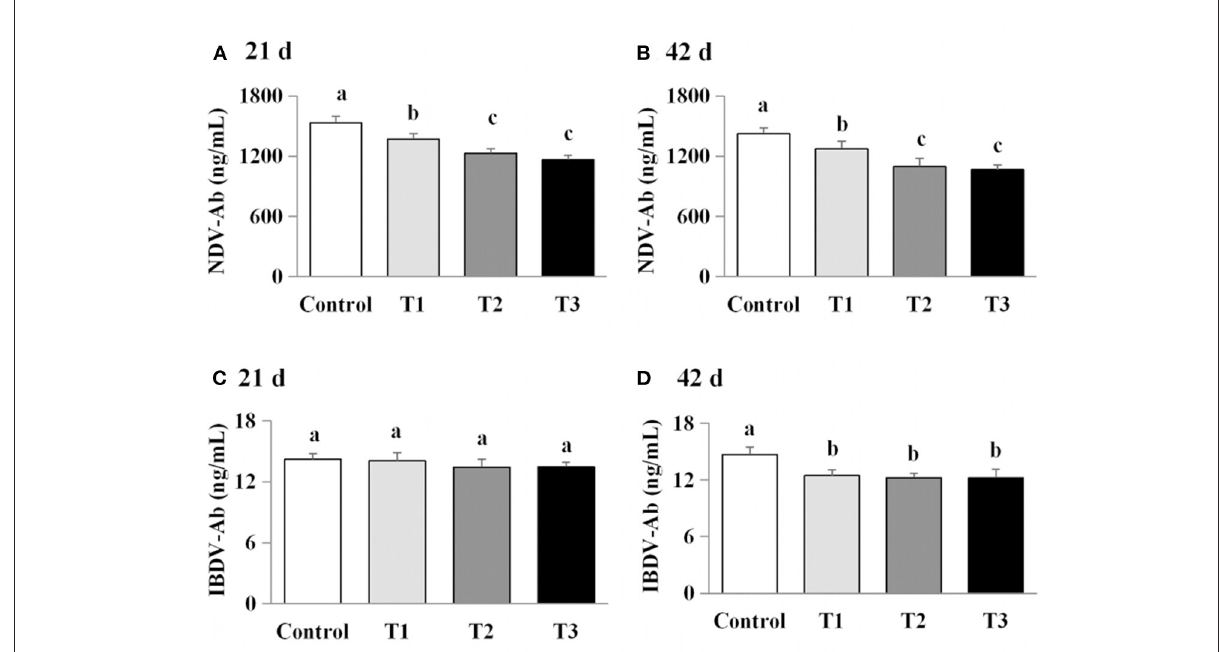
FIGURE4 Effects of AFB 1 on the antibody content in serum of chicks on day 21 and day 42. (A) IBDV-Ab content on day 21. (B) IBDV-Ab content on day 42. (C) NDV-Ab content on day 21. (D) NDV-Ab content on day 42. Control: control group. T1: low doses of AFB 1 group. T2: medium doses of AFB 1 group. T3: high doses of AFB 1 group. Data represent the means ± SD values of six replicate cages and were compared using one-way analysis of variance (ANOVA) followed by Duncan’s multiple comparison tests. Different letters on the same row indicate significant differences ( P < 0.05).